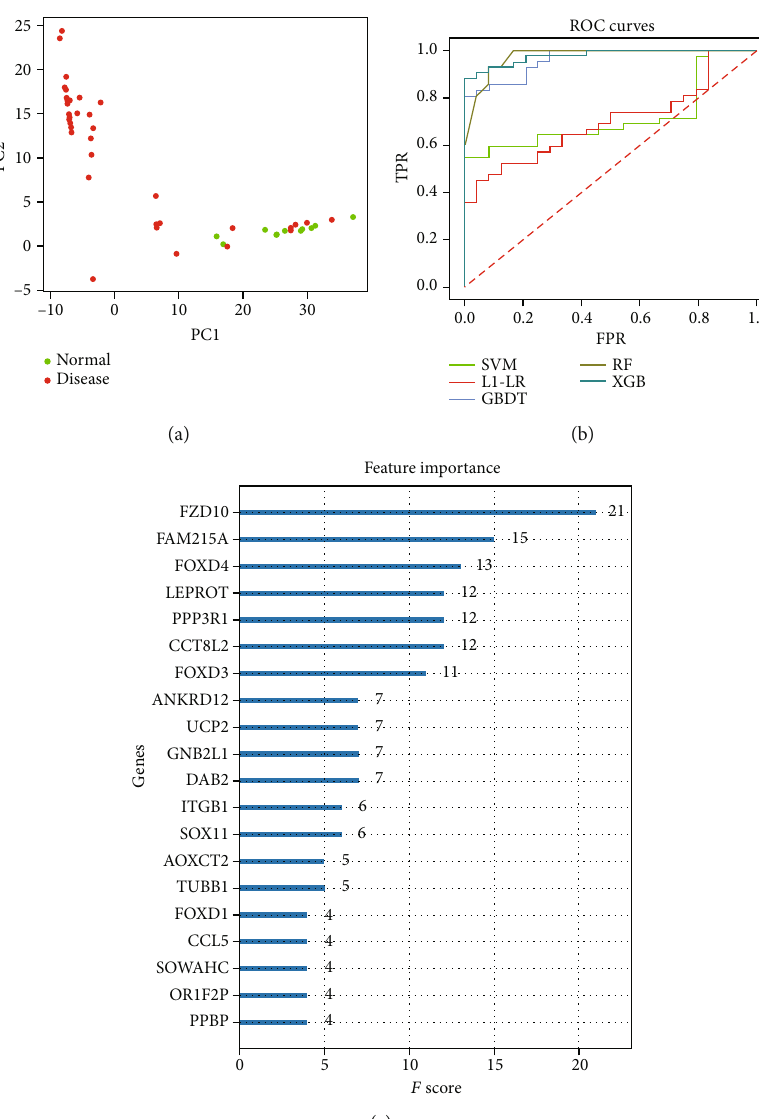
Figure 5: The model simulation. (a) Principal Component Analysis (PCA) results. PC1 and PC2, respectively, represent the two principal components with the largest variance value in PCA results. The points with di ff erent colors in the fi gures represent the Disease and Normal samples, respectively. (b) ROC curves analysis for the comparison of fi ve training models. FPR represents False Positive Rate ð FP/ ð FP + TN ÞÞ , and TPR refers to True Positive Rate ð TP/ ð TP + FN ÞÞ . Various colors represented di ff erent training models. A larger area under ROC curves indicated a better prediction feature of models. (c) The top 20 features were evaluated by the XGB model. F score indicates the feature importance. A larger F score refers to the more importance of the gene in the XGB model. Table 2: The optimal parameters of di ff erent models were calculated for the validation of the test dataset. Models Primary parameters